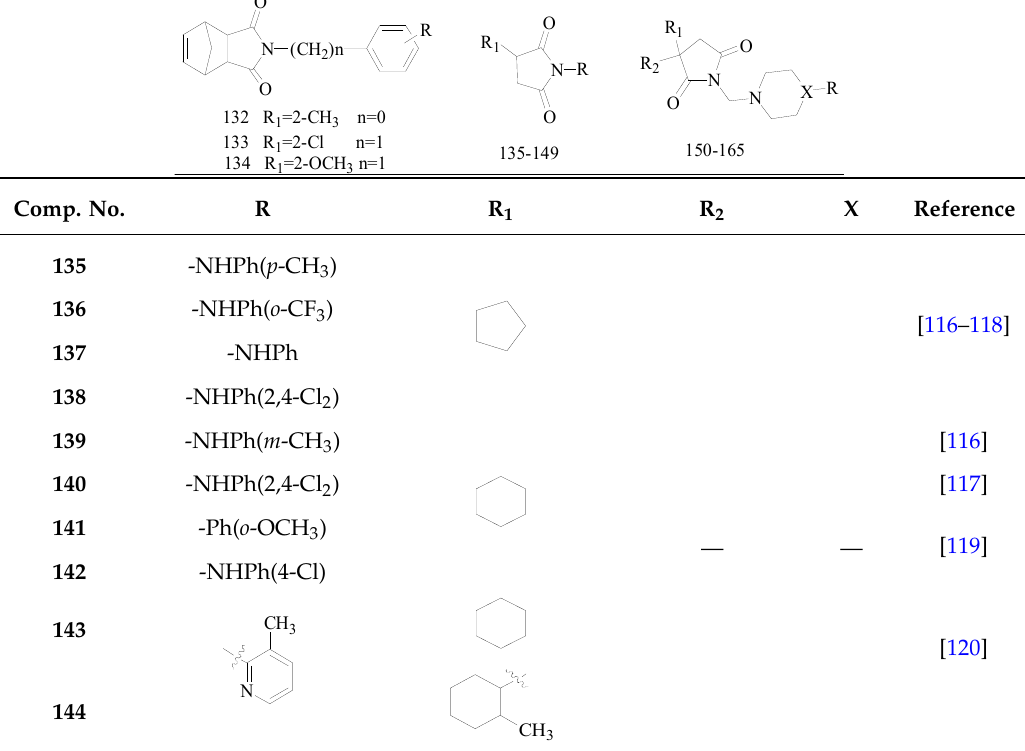
Table 7. Structures of compounds 132 – 165 .